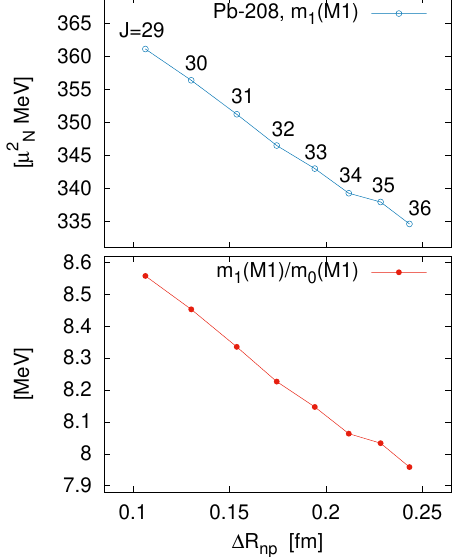
Figure 9. The same as Figure 8 but for 208